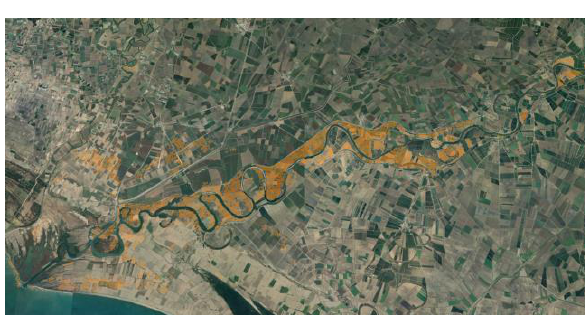
Figure 4. Agriculture zone affected by the flood